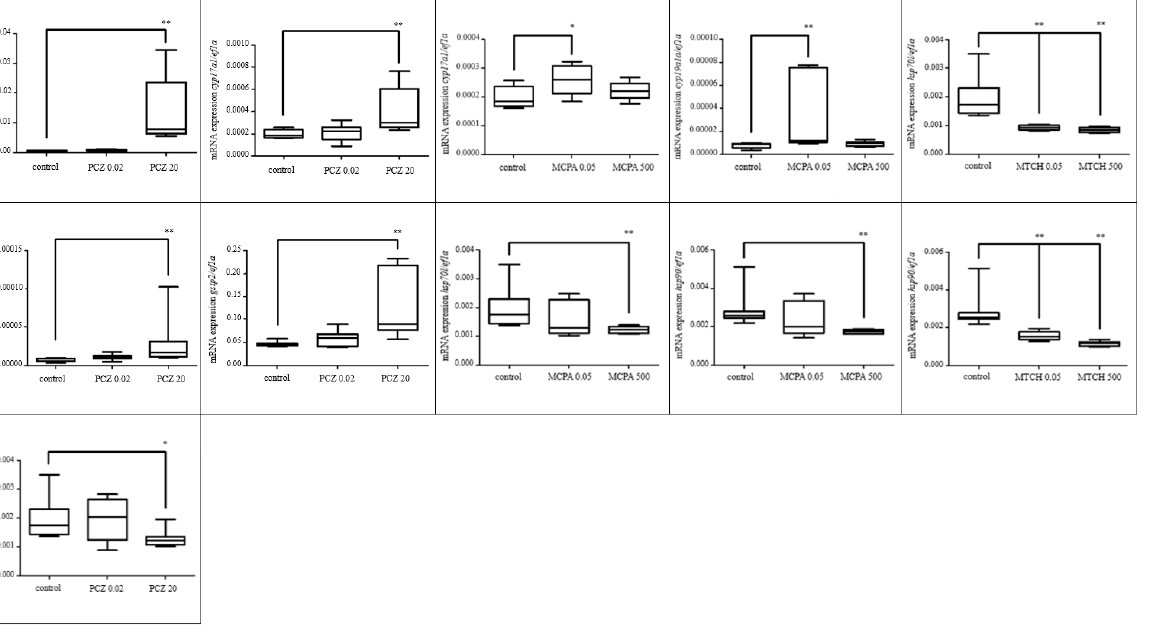
Figure 2. Relative mRNA expression of selected genes in C. carpio embryos exposed to MCPA. Con- centrations are indicated in µg/L. Box plot graphs were constructed using median, Q1, and Q2 with whiskers of a maximum 1.5 interquartile range. Statistically signi fi cant di ff erences are indicated by ** ( p < 0.01).